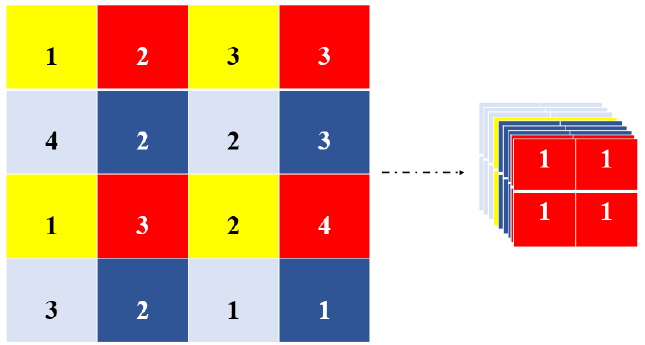
Figure 5. The processing flow of focus module.